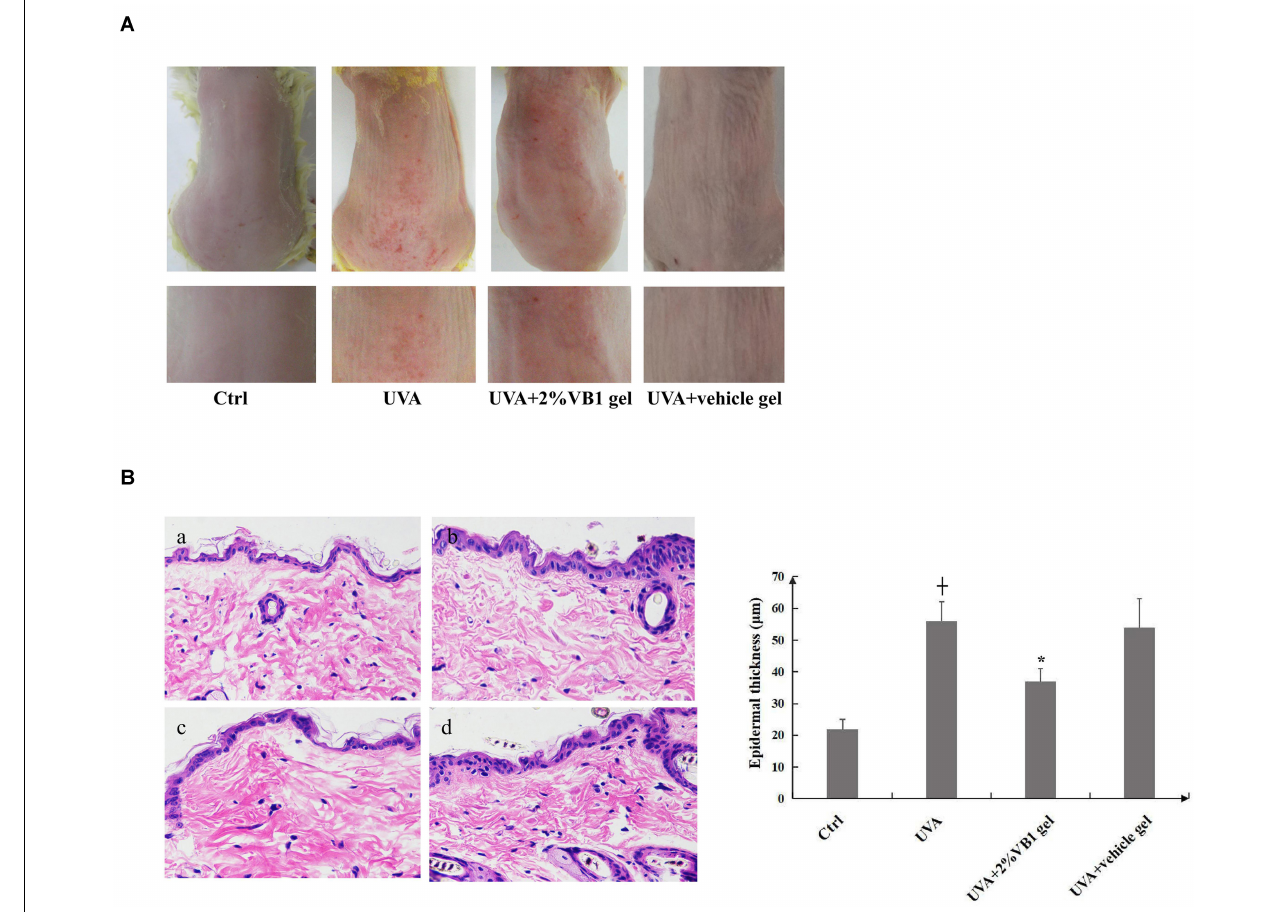
FIGURE 5 | Topical VB1 gel palliates skin photoaging phenotype induced by UVA irradiation in mice. Mice were irradiated with UVA 3 times per week at doses of 20 J/cm 2 for 12 weeks. A gel containing 2% VB1 or a vehicle gel lacking VB1 (negative control) was applied topically to the dorsal skin areas of mice at 1 h after each irradiation. The control group consisted of untreated mice at the same age. (A) Representative photographs of mice dorsal skin in mice from control group, UVA-irradiated group, the experimental group receiving VB1 gel and the vehicle only group. (B) Representative photographs of hematoxylin-eosin (HE)-stained dorsal skin sections obtained at the end of the experiment from (a) control group, (b) UVA-irradiated group, (c) the experimental group receiving VB1 gel and (d) the vehicle only group (left panel, magnification 200x). Epidermal thicknesses were estimated at 5 different random sites with each mouse from digital images of HE-stained sections and are depicted as means ± SEM ( n = 10 per group). The right panel showed the analysis data (+ vs. ctrl, p < 0.05, * vs. UVA, p <